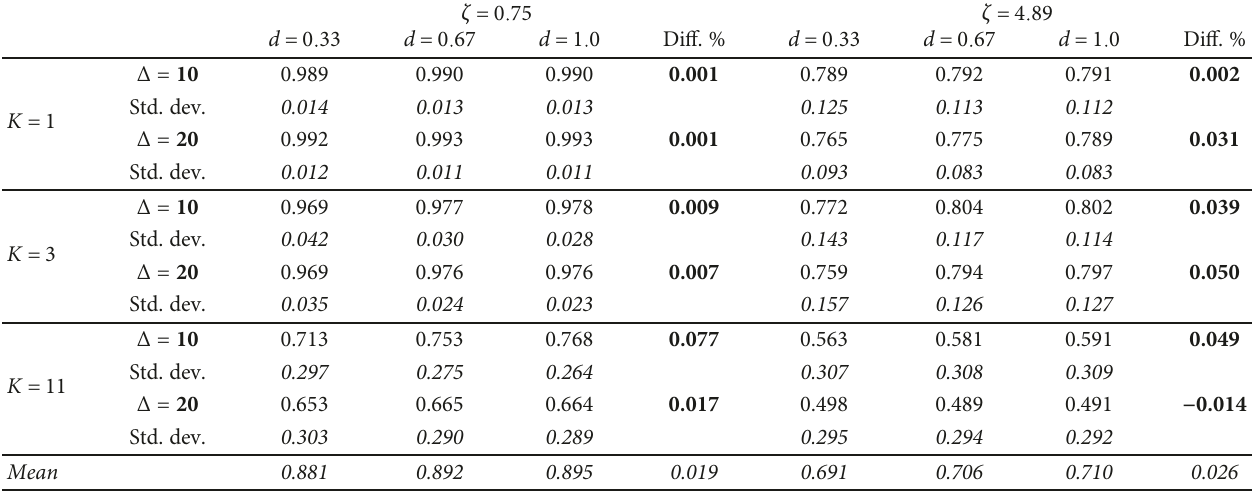
Table 2: Results for M = 11 with density =1.